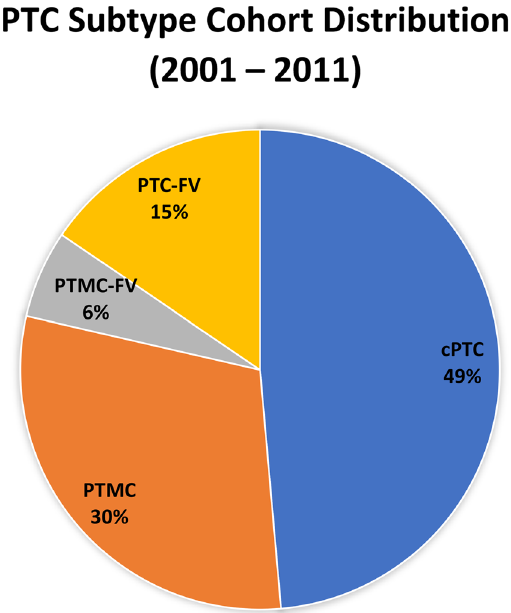
Figure 2. Pie graph showing the frequency of each PTC histopathologic subtype: 123 cases of cPTC (49%), 76 cases of PTMC (30%), 15 cases of PTMC-FV (6%), and 39 cases of PTC-FV